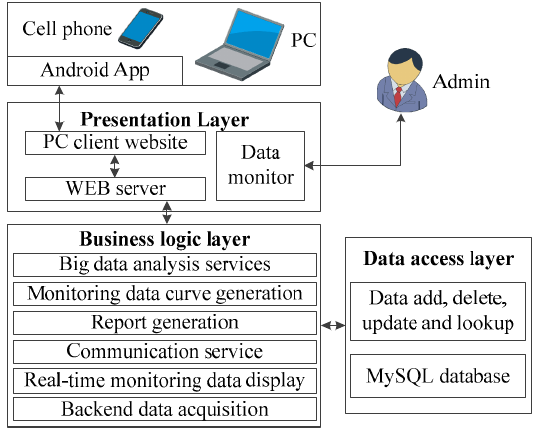
Figure 4. Block diagram of the software.